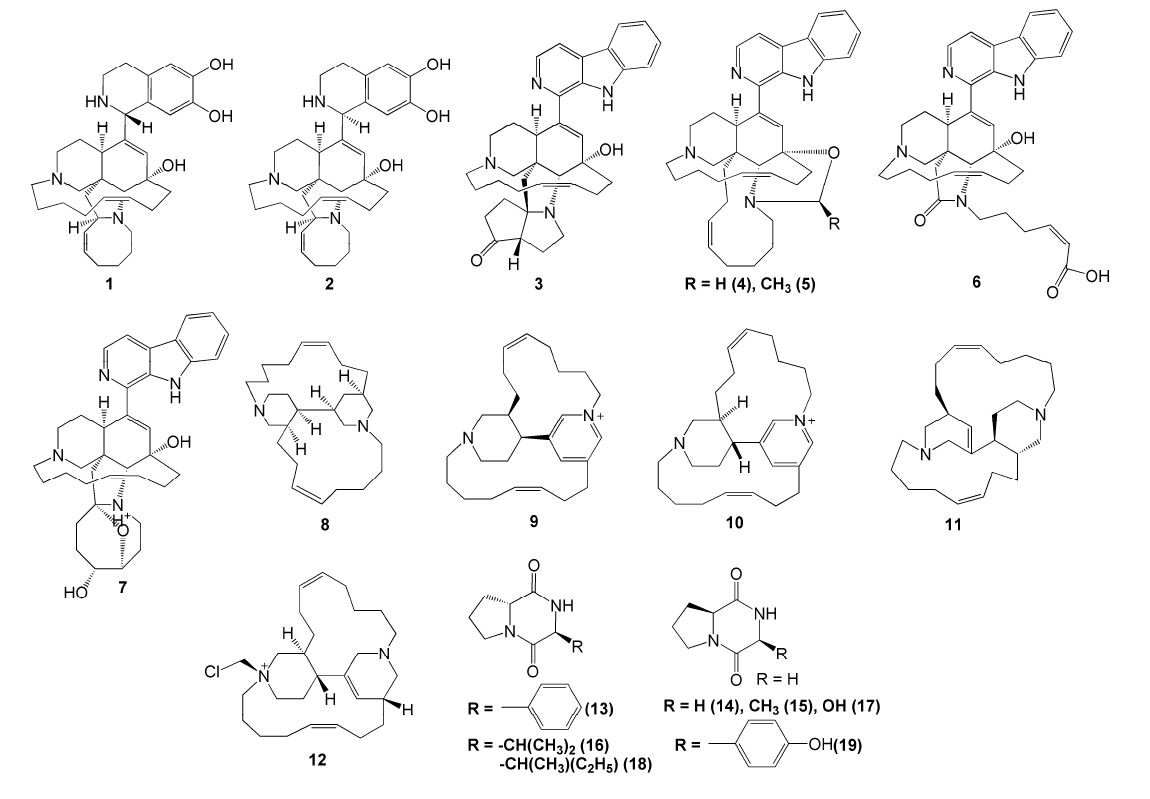
Figure 1. Chemical structures of 1 – 19.